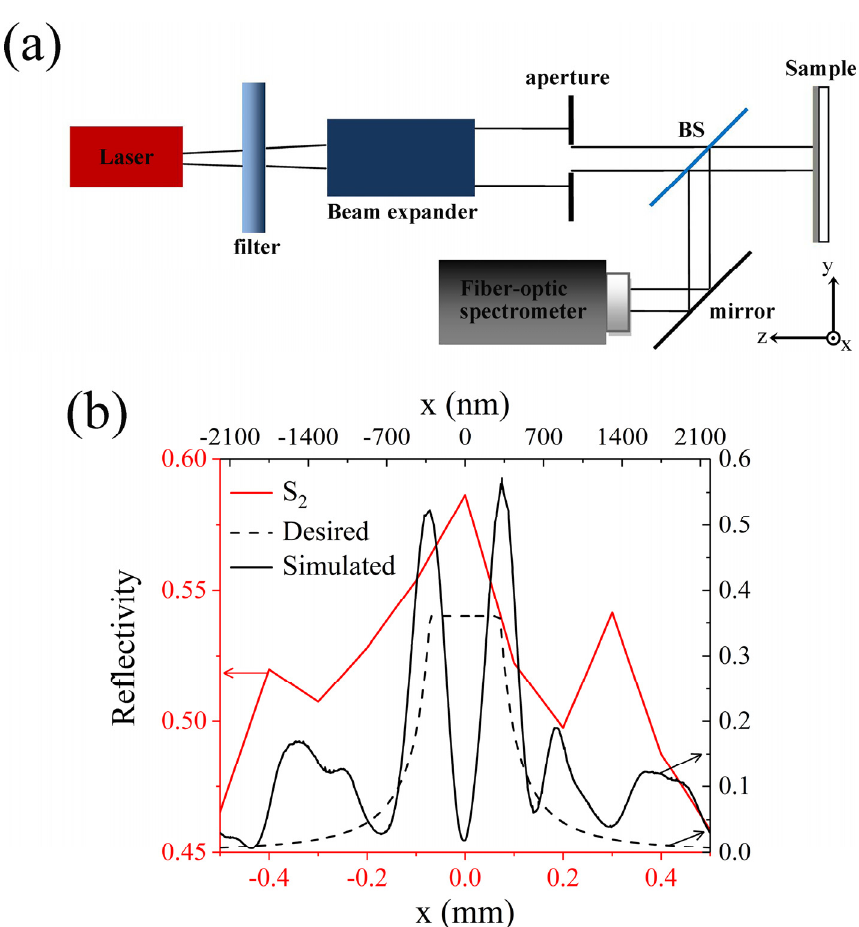
Figure 5. Experiment on the integral property of the dendritic metasurface sample. ( a ) Schematic of the experimental device for measuring the reflected light intensity of the sample. ( b ) Distribution of normalized co-polarized reflected light intensity (i.e., reflectivity) of sample S 2 along the x-axis.